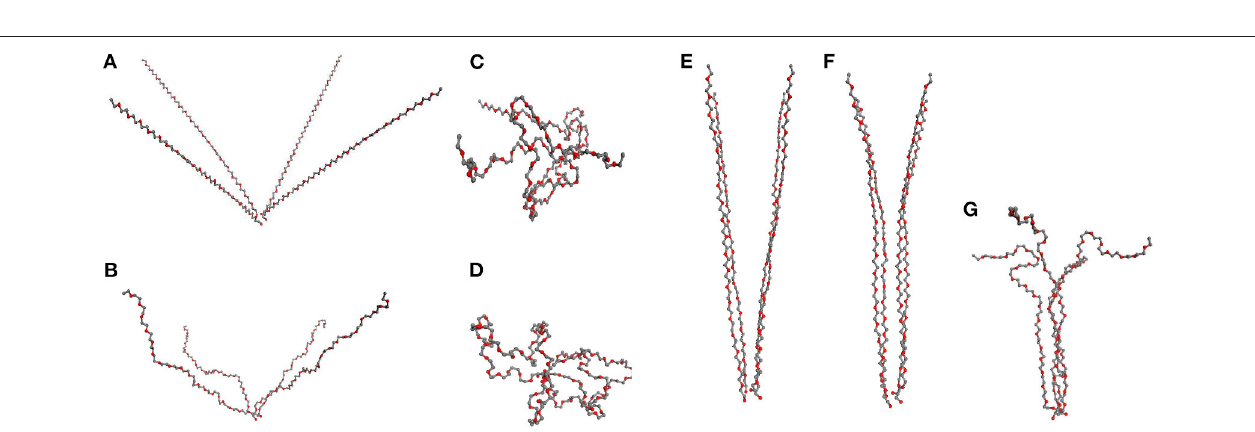
FIGURE 6 | Mechanism of fibrillar structure formation in the network model: (A) Reversible transitions of single flexible chain (green). (B) Specific configuration of two unstretched chain, observed during quick deformation. (C) Specific configuration of two chains, observed during slow deformation.